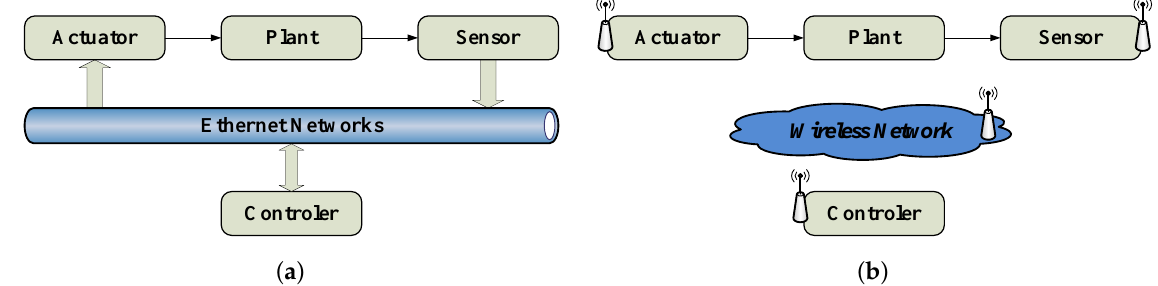
Figure 1. ( a ) Representation of a NCS and ( b ) Representation of a